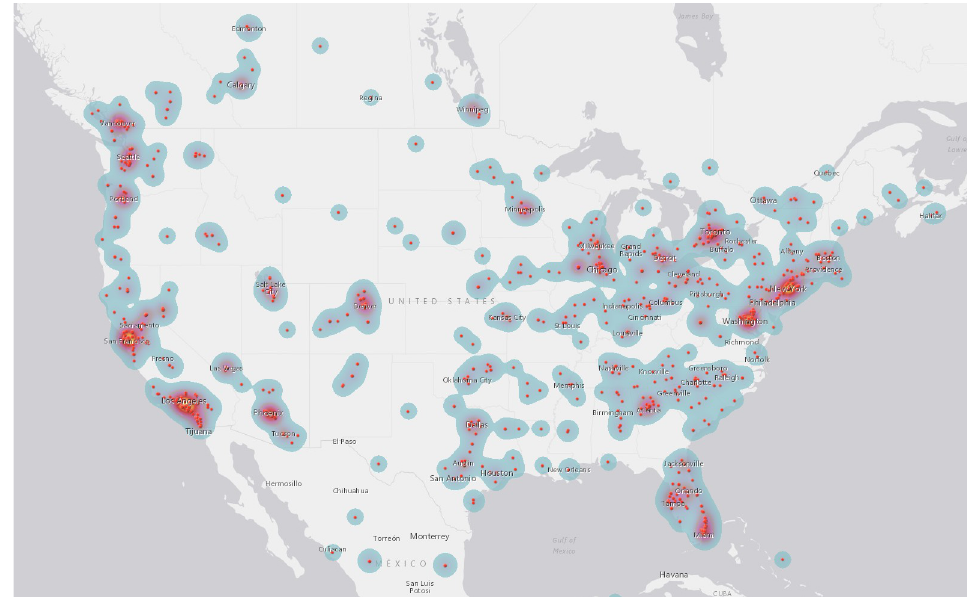
Fig 1. US campaigner